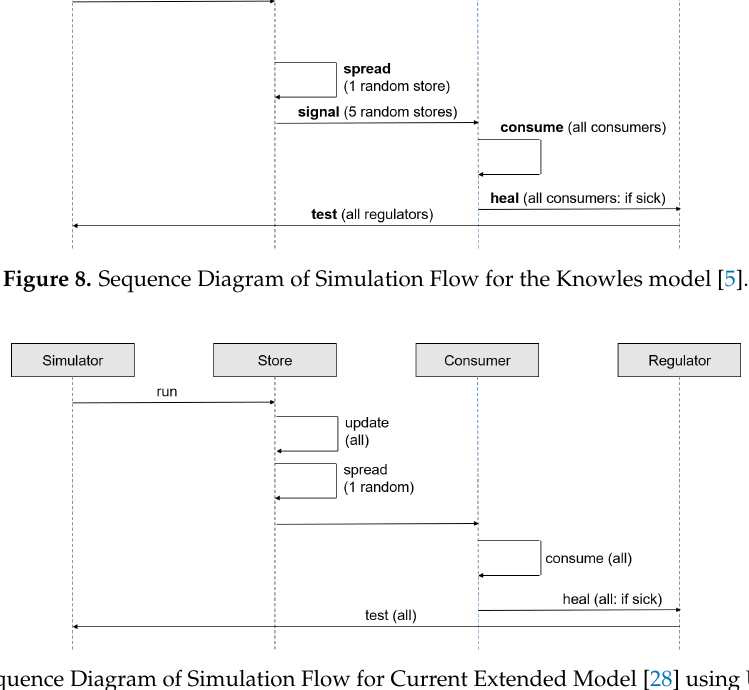
Figure 9. Sequence Diagram of Simulation Flow for Current Extended Model [28] using UPDATE but without